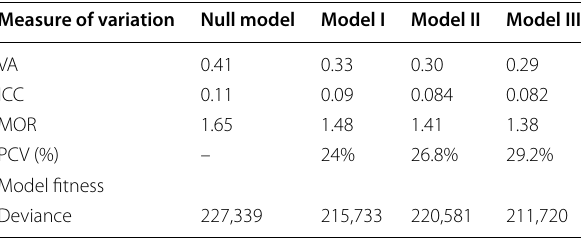
ICC inter cluster corrolation cofficent, MOR median odds ratio, PCV proportional change in variance